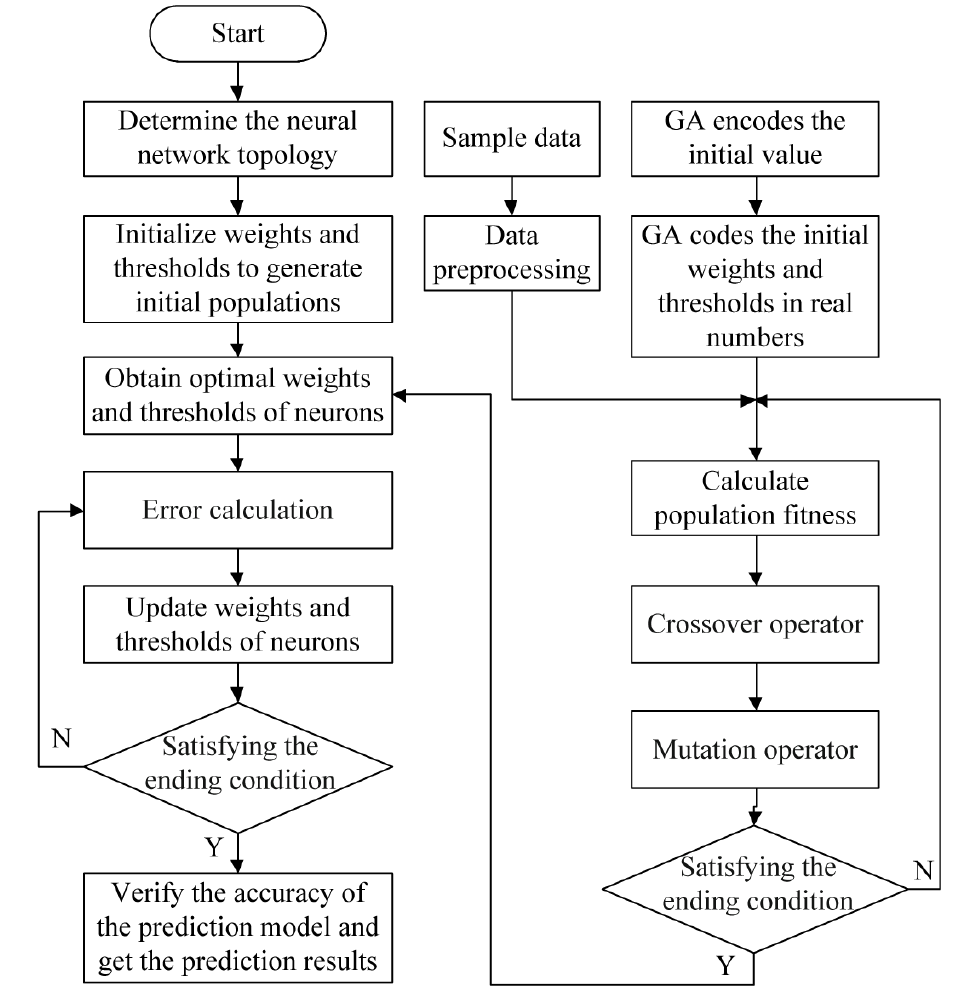
Figure 2. Flowchart of GA-Elman